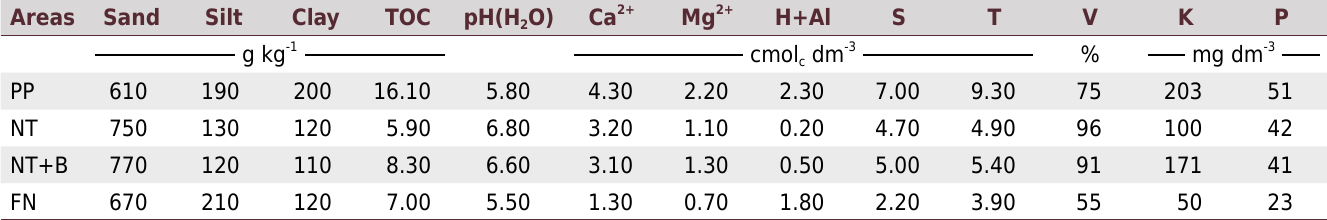
Table 2. Characterization of physical and chemical soil attributes in the 0.00-0.10 m layer in the study areas in the subtropical region of Brazil Areas